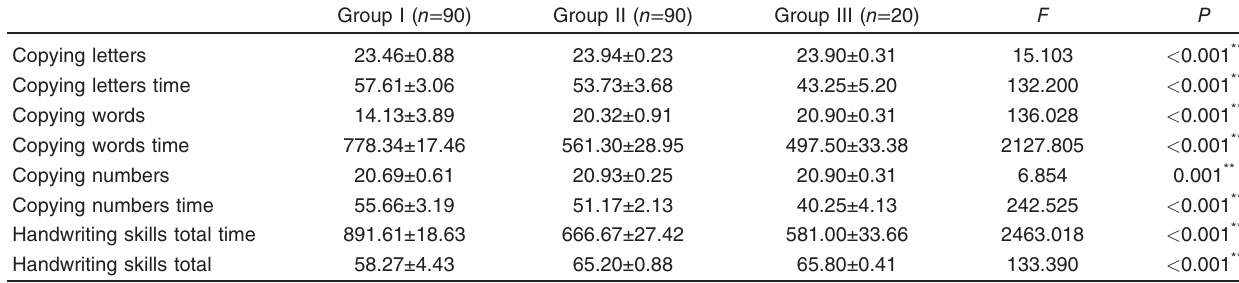
Table 2 Comparison among the studied groups in their performance in handwriting skills